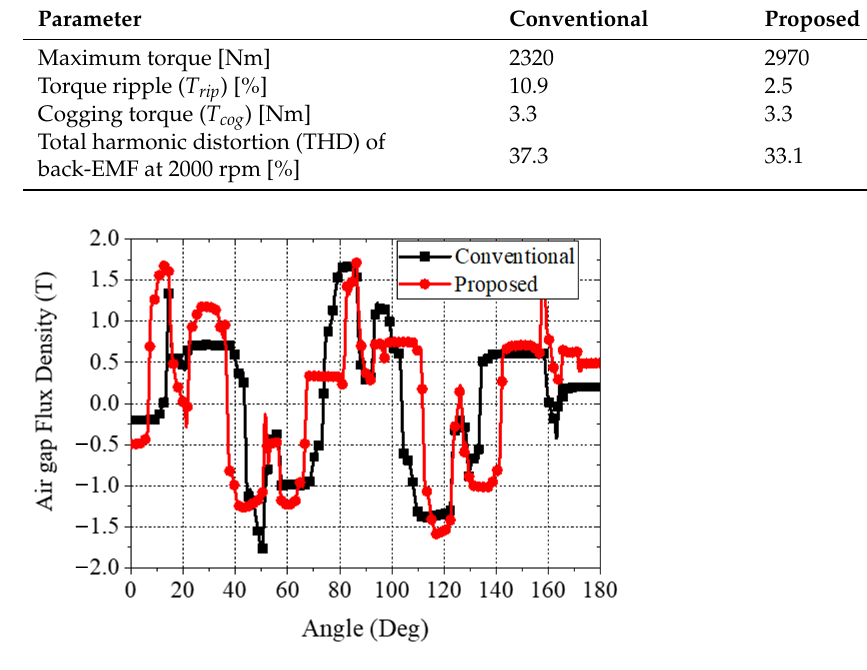
Figure 8. Air gap flux density at the maximum current.